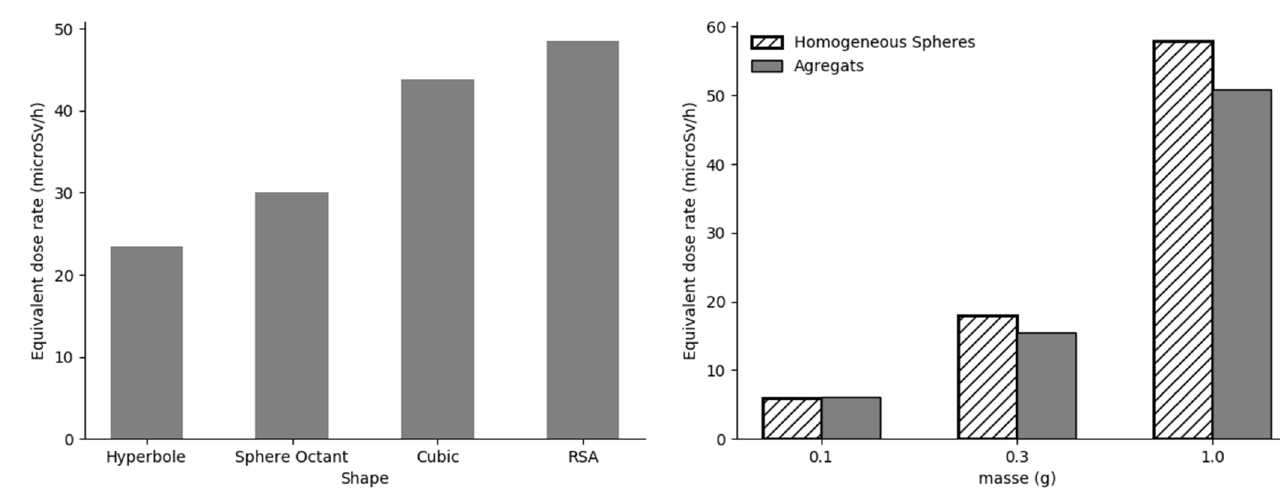
Fig. 13. Comparison between Gamma equivalent dose rate obtained with an inclusion of homogenized spheres and an inclusion of dense packing of 12 spheres inside a sphere of the same radius of the homogeneous one.